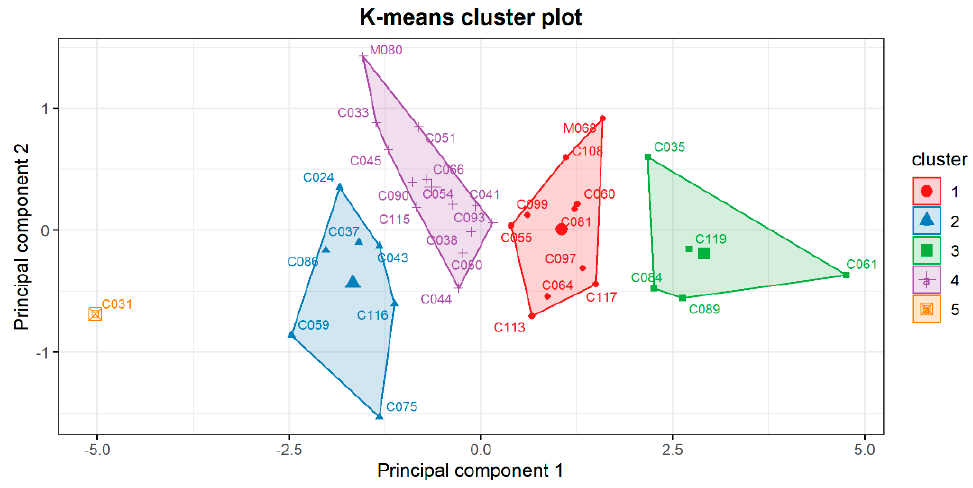
Figure 3. Clustering of colorectal cancer patients according to k-means and principal component analysis.